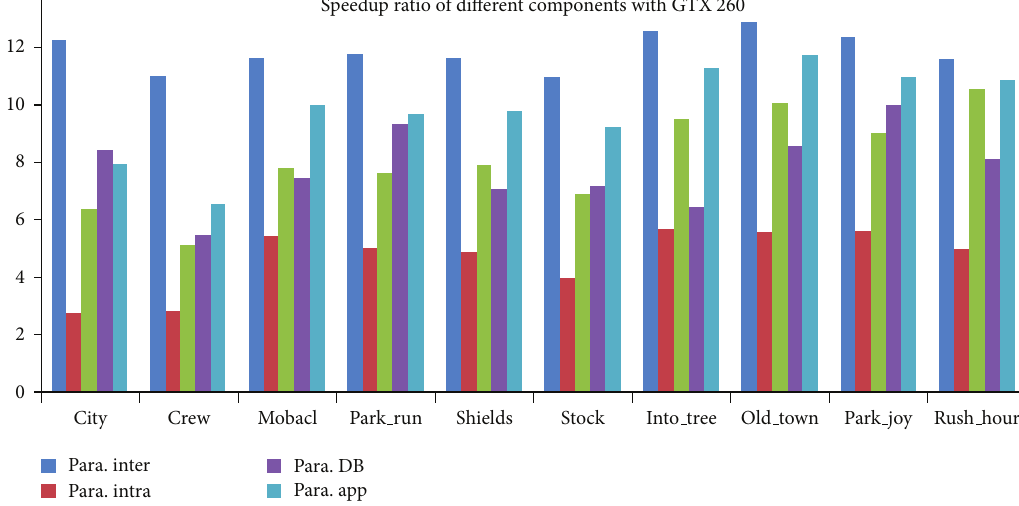
Figure 16: Speedup ratio of the proposed parallel H.264 encoder on GTX260.